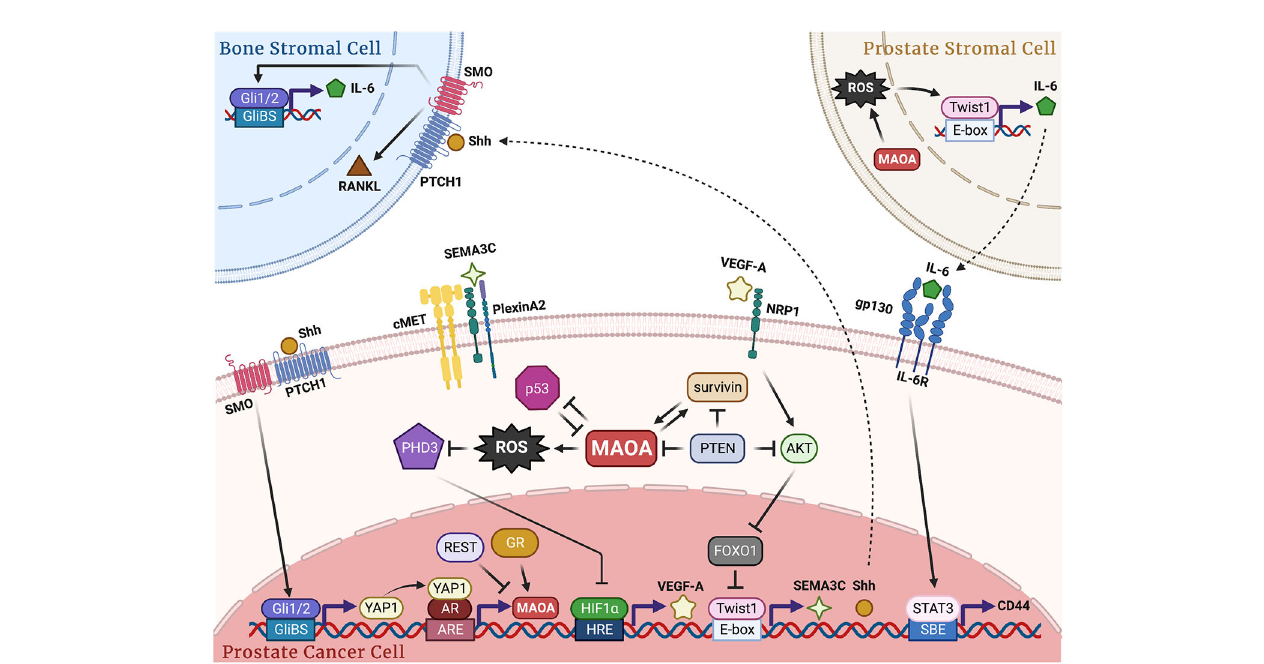
FIGURE 1 Schematic of the molecular mechanisms by which MAOA promotes PC growth, progression and metastasis. In PC cells, MAOA generates ROS to repress PHD3, which stabilizes HIF1 a and induces VEGF-A/NRP1 signaling to upregulate the AKT/FOXO1 pathway, resulting in activation of Twist1 by relieving FOXO1 transcriptional suppression with subsequent induction of Shh and SEMA3C in a Twist1-dependent transcriptional manner. Next, Shh interacts with PTCH1 to relieve depression of SMO and activate Gli1 and Gli2, which transcriptionally induces YAP1 to enhance YAP1-AR interaction, promoting AR transcriptional activity and fueling AR-reliant cancer growth. SEMA3C interacts with PlexinA2 and NRP1 to stimulate cMET for perineural invasion. Upstream regulators AR, GR, REST, PTEN, p53 and survivin cooperatively contribute to MAOA gene regulation either in a known transcriptional manner or through an unidenti fi ed mechanism. In cancer-bone stromal cell crosstalk, MAOA-expressing cancer cells secrete Shh via PTCH1/SMO to activate Gli1 and Gli2 in osteoblasts in a paracrine manner, which in turn induces the expression and release of IL-6 and RANKL from osteoblasts to promote osteoclastogenesis and subsequent bone metastasis. In prostate stromal-cancer cell crosstalk, MAOA in stromal fi broblast cells triggers IL-6 transcription and expression in a ROS/ Twist1-dependent manner, which in turn interacts with gp130/IL-6R expressed in cancer cells for STAT3-dictated transcriptional activation of CD44 to confer cancer stemness. GliBS, Gli-binding site; ARE, androgen response element; HRE, hypoxia response element; SBE, STAT-binding